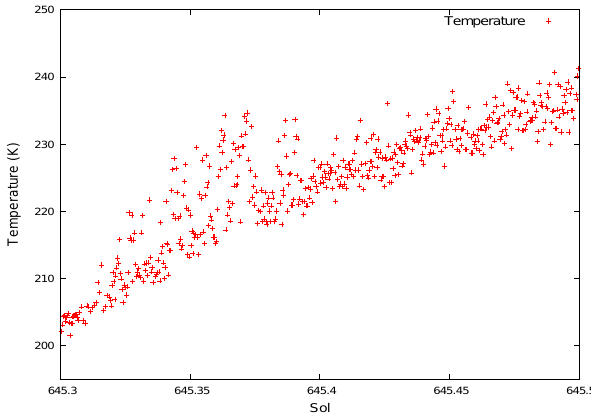
Fig. 5. ULT VL2 noon, midnight and sol mean temperature data of the whole mission.